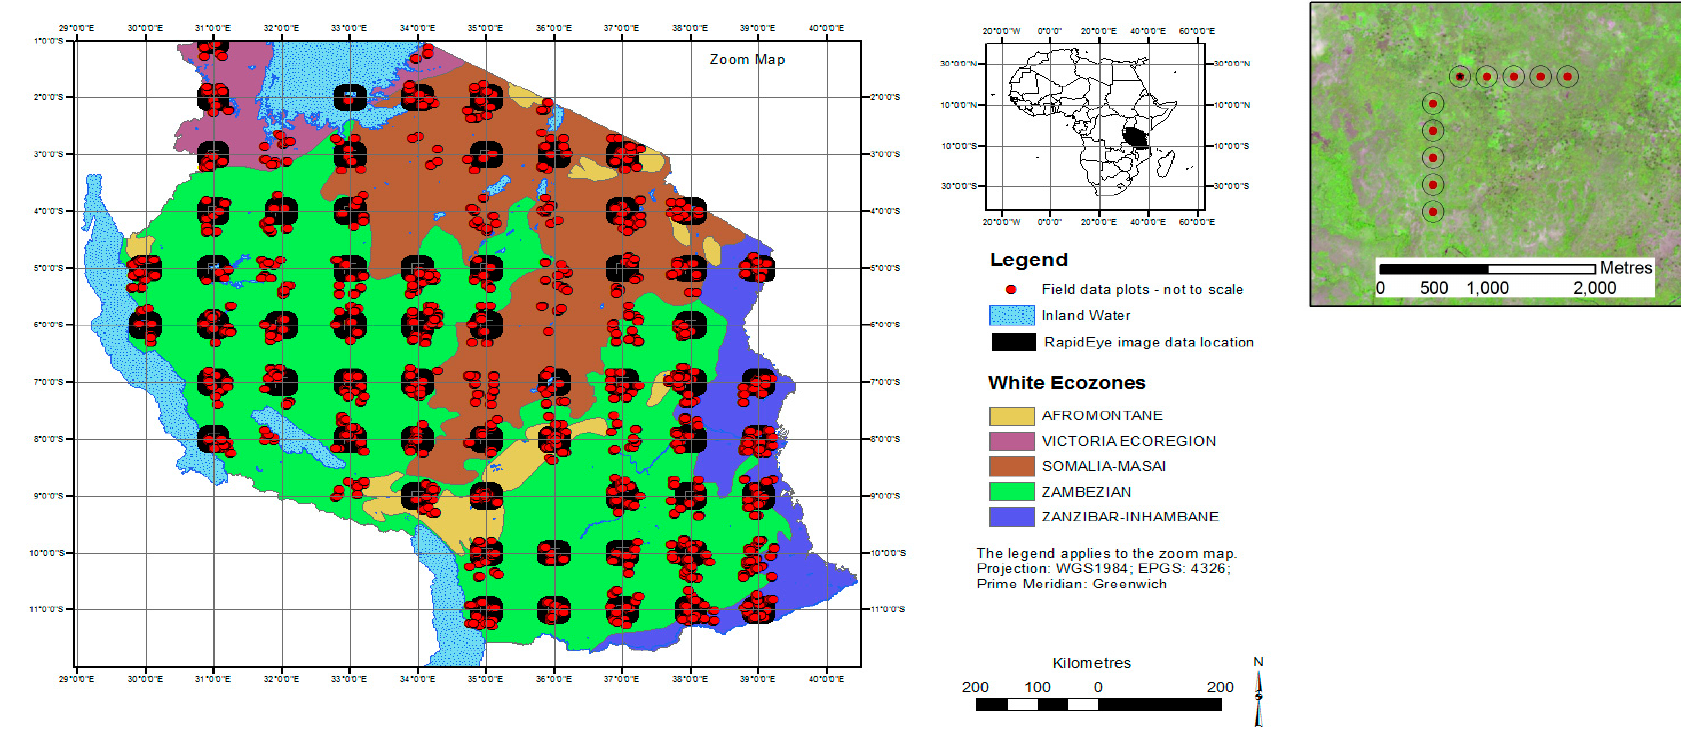
Figure 1. The ecological zone map of Tanzania [54] with the location of the field plots (not to scale) to coincide with the satelite data. An excert of the points for one cluster overlaid on a RapidEye image is shown to the right.